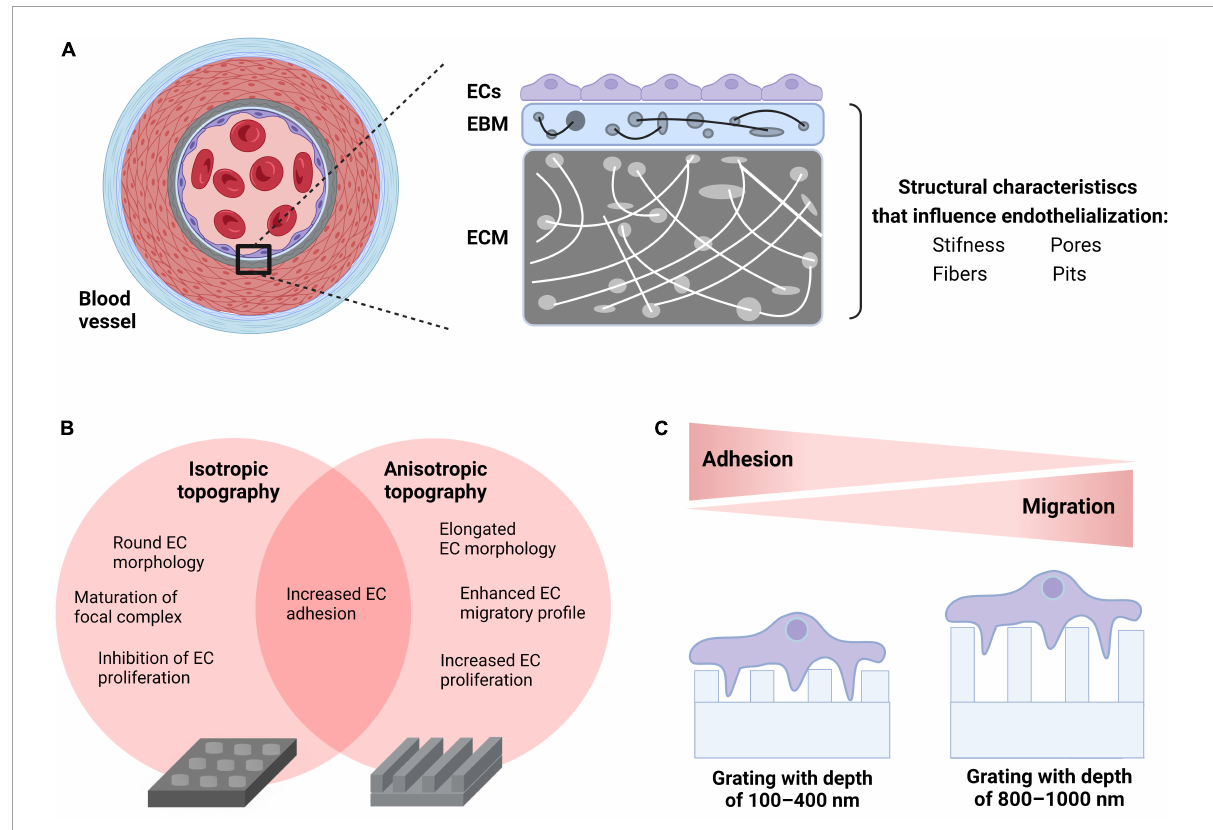
FIGURE1 Incorporation of biomechanical cues to enhance endothelialization of CV implants. (A) Physiological properties of human vascular tissue such as physical (e.g., stiffness) and morphological (e.g., fibers, pores, and pits) characteristics dictate the EC-EBM-ECM interplay generating biomechanical cues that influence endothelialization. (B) Choice of surface geometry: ECs seeded on isotropic topographies (e.g., wells) obtain a round cellular morphology, migrate less due to the maturation of focal complexes into FAs and show low proliferation rate. In contrast, ECs seeded on anisotropic topographies such as gratings acquire an elongated cell morphology that enhances both migration and proliferation. Both surfaces increase cell adhesion under static and flow conditions. (C) Adjusting the surface topography: EC monolayers on shallow gratings (100–400 nm depth) interact with both the top of the ridges and the bottom of the grooves promoting FA complex maturation and enhancement of cell-surface adhesion, whereas EC monolayers on deep gratings (800–1,000 nm depth) bridge over grooves resulting in an increase in FAK activity due to enhanced phosphorylation as well as improved migratory ability. This figure was created with